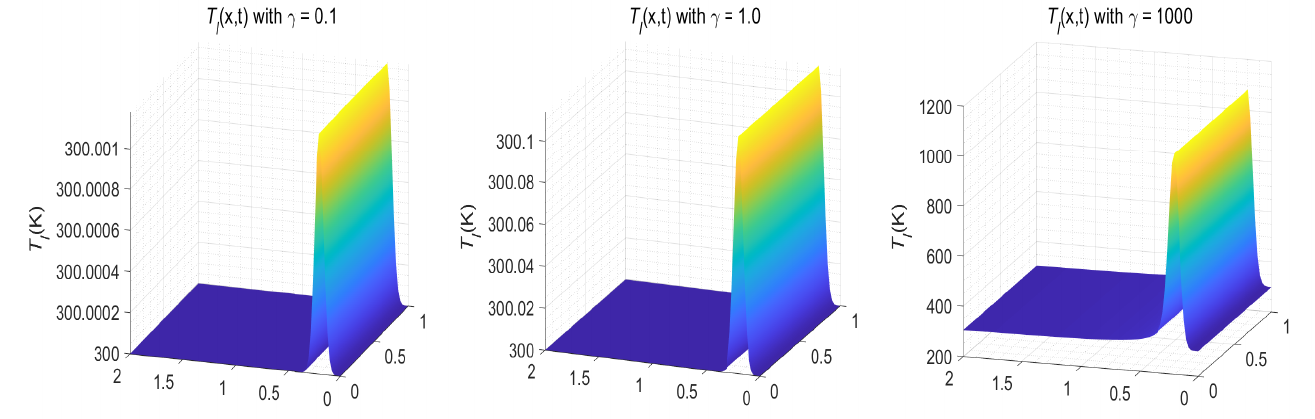
Figure 24. Temperature distributions of T l versus ( x , t ) with various γ when K n = 618.4658, ( α , β ) = ( 0.1,0.1 ) , N = 100, and M = 100 for Example